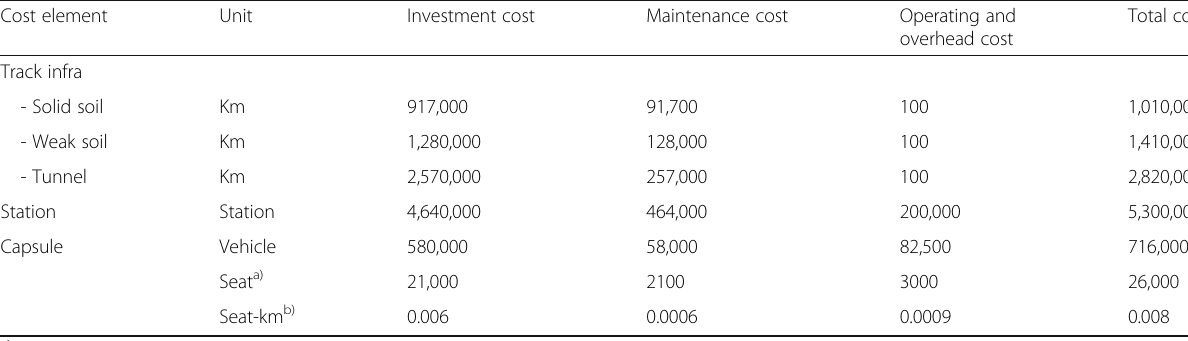
Table 4 Estimated annual costs of the HL system ( €